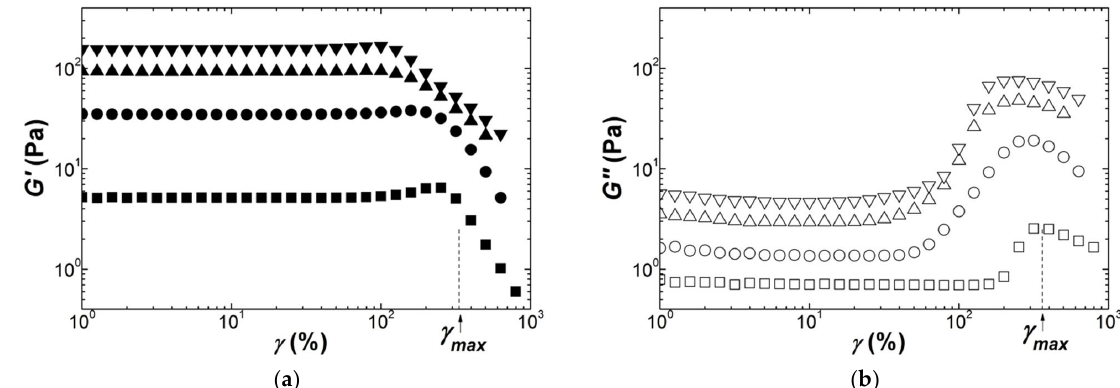
Figure 5. Response of Iota gels (squares: 0.3 wt.%; circles: 0.7 wt.%; up triangles 1.2 wt.%; down triangles: 1.7 wt.%) to a sweep in the dynamic shear strain γ at 1 Hz and 20 °C: ( a ) storage modulus G′ ; ( b ) loss modulus G ″. γ max signals the strain where G ″ passes through a local maximum for the gel with 0.3 wt.% Iota.